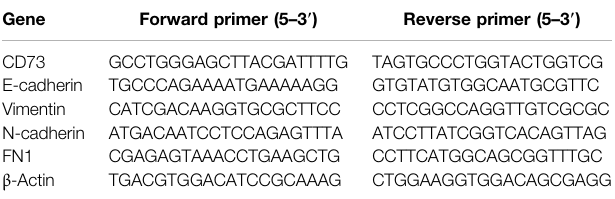
TABLE 1 | Primer sequence used in qRT-PCR